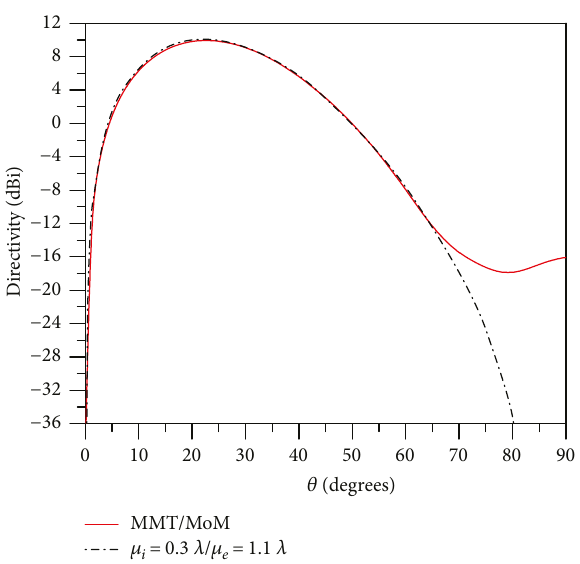
Figure 4: Generatrices and ray tracing of the classical omnidirectional ADE antenna.